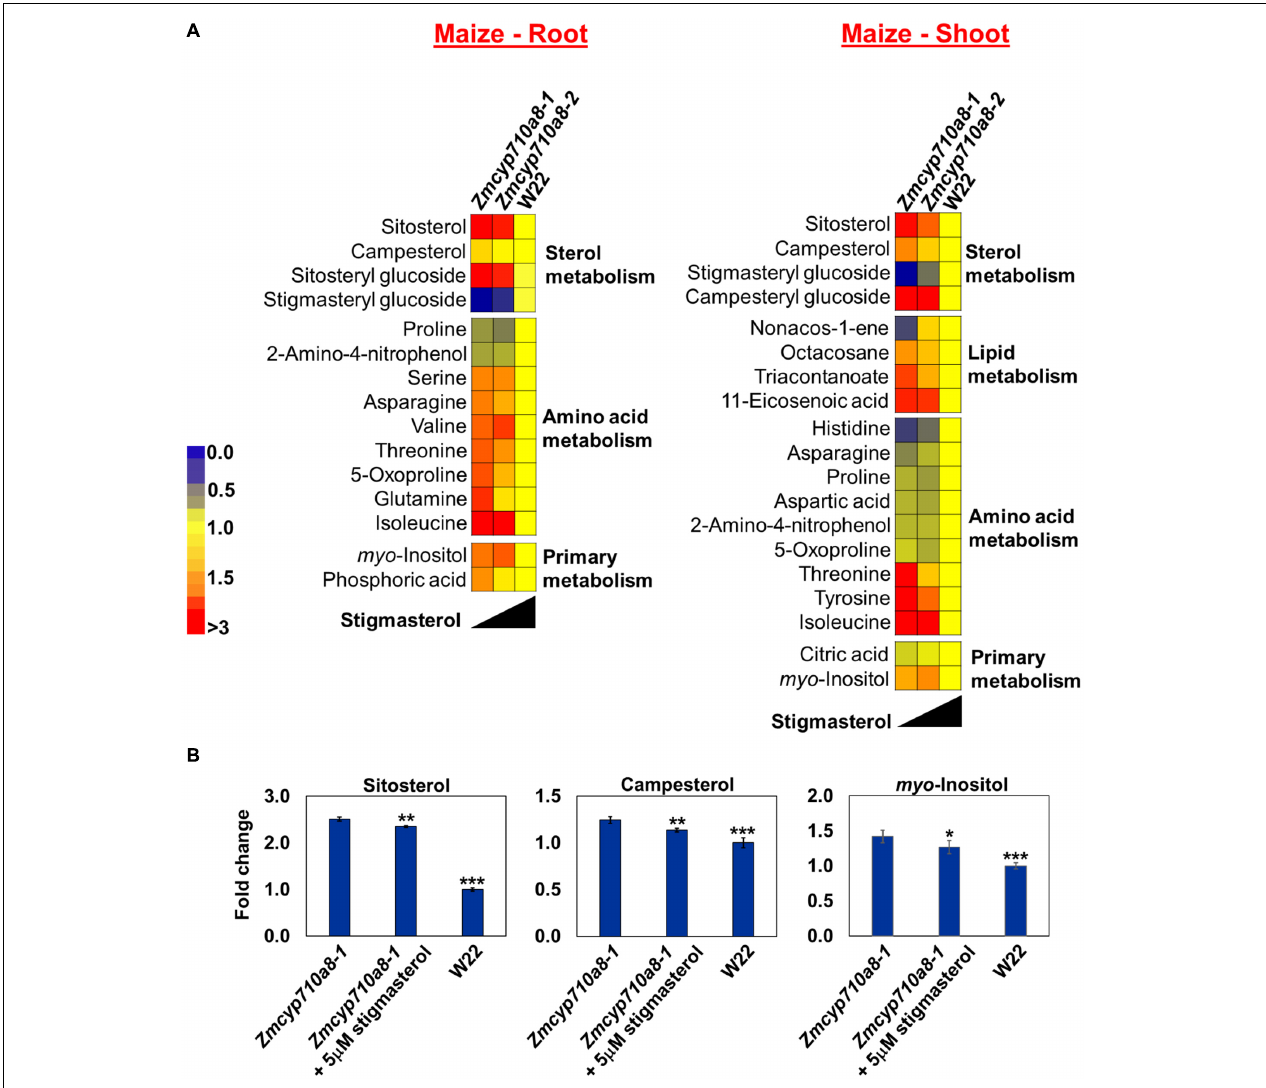
FIGURE 7 | Stigmasterol modification impacts metabolite profile in root and shoot tissues of Zmcyp710a8 mutants. (A) Non-targeted metabolite profile from roots and shoots of wild type and the Z mcyp710a8 mutants were analyzed as described in section “Materials and Methods.” Relative metabolite levels in the two maize mutant alleles compared to their wild type are shown as fold changes in roots and shoots. The colors indicate the degree of fold change relative to wild type as shown in the color scale. (B) Fold changes of selected metabolites in the root tissue of Zmcyp710a8-1 mutant allele with exogenous stigmasterol feeding. Asterisks indicate statistical significance by Students t -test compared to Zmcyp710a8-1 . * P < 0.05; ** P < 0.01; *** P <